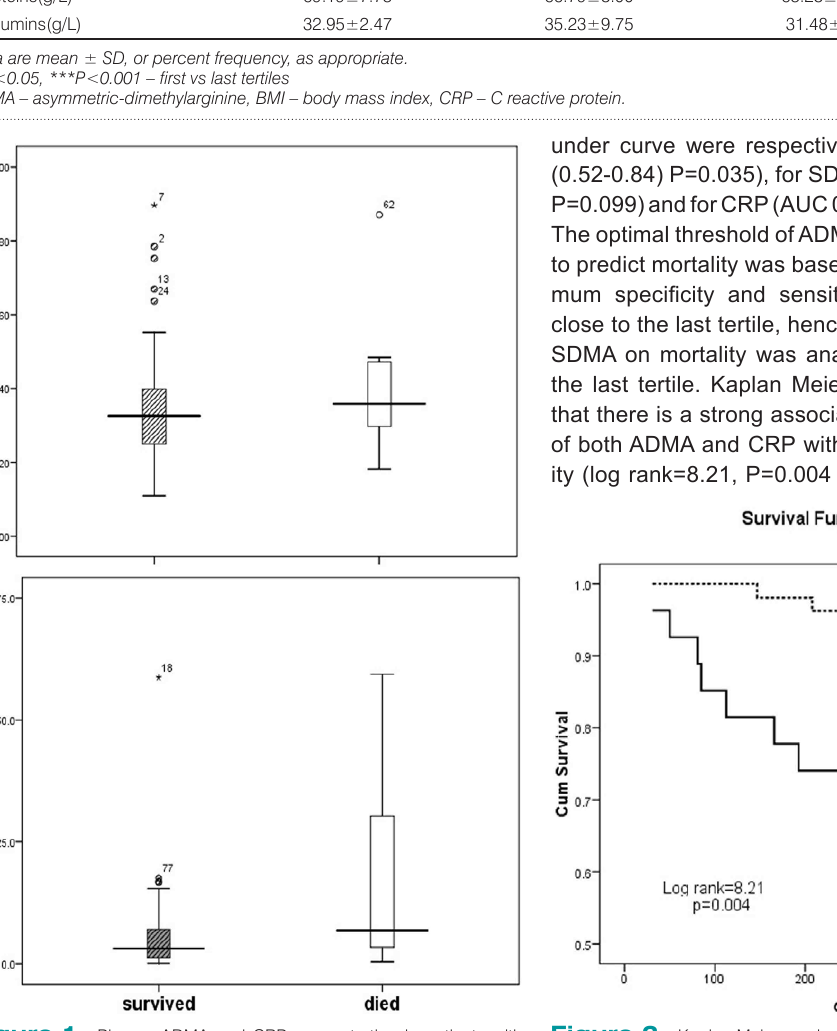
Figure 2. Kaplan-Meier survival analysis for all-cause mortality of plasma ADMA. Patients were divided into two groups: low ADMA (first and second tertiles) – dotted line; high ADMA (highest tertile) – solid line.